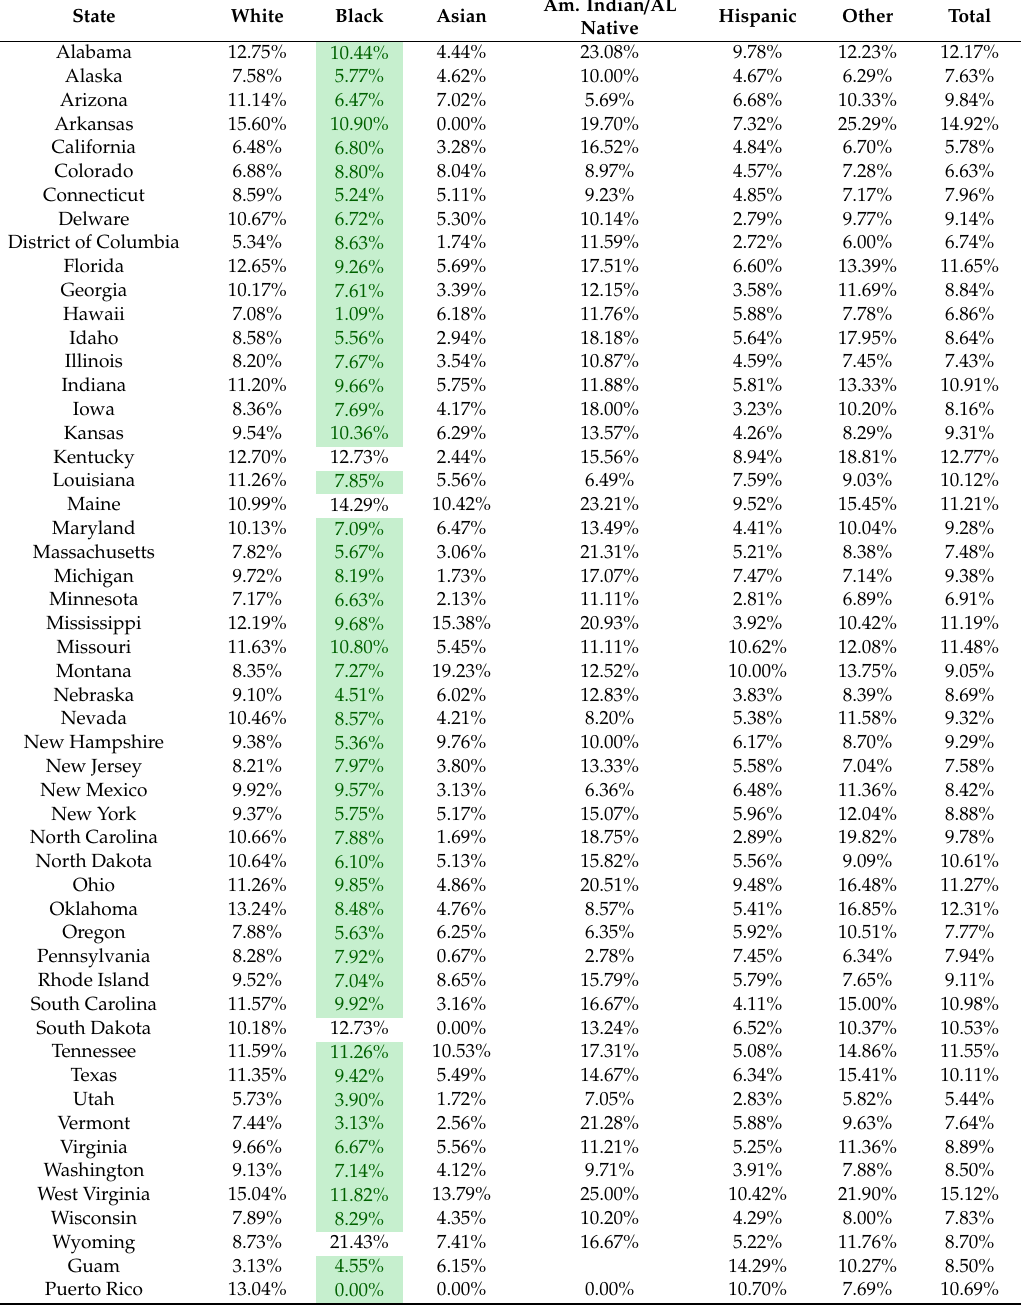
Am. Indian / AL Native